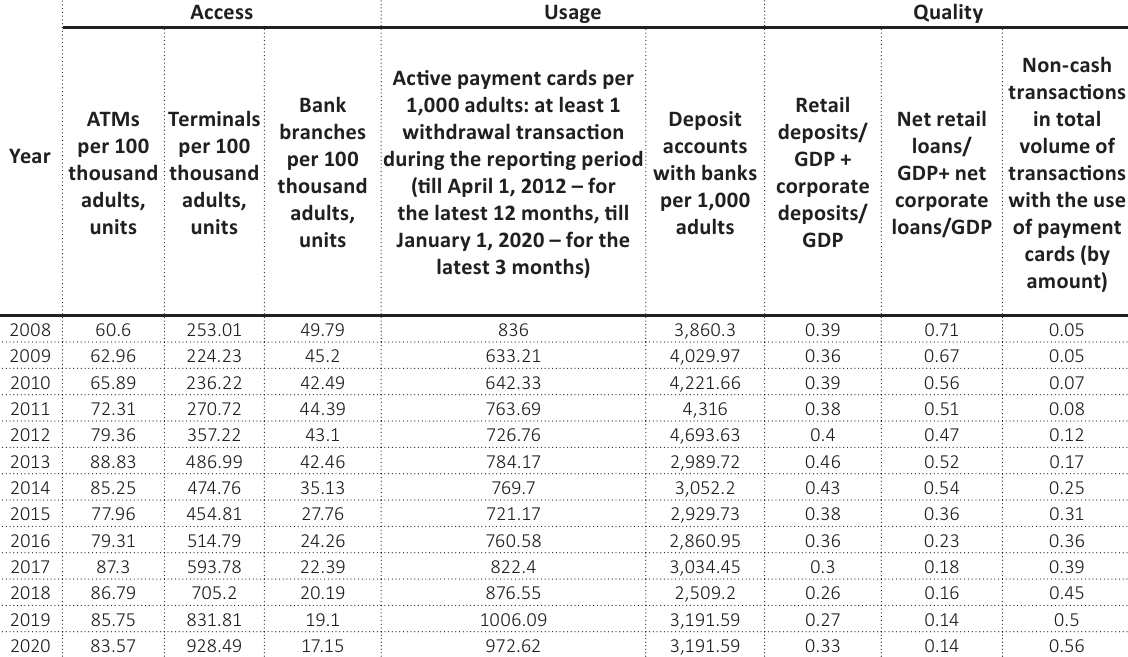
Table 1. Dimensions of the Ukrainian financial inclusion level,